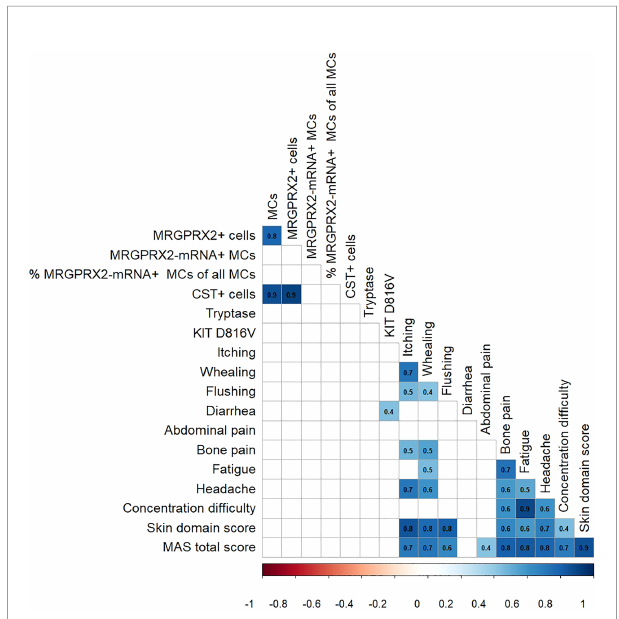
FIGURE 4 | Correlation of MRGPRX2 and its agonists in the skin with the clinical and laboratory parameters in patients with ISM.The color shades represent the value of the Spearman correlation coef fi cient (r) and the relationship (red and blue are negative and positive r values, respectively). Only statistically signi fi cant correlations are shown (p < 0.05). CST, cortistatin; MAS, mastocytosis activity score; MC, mast